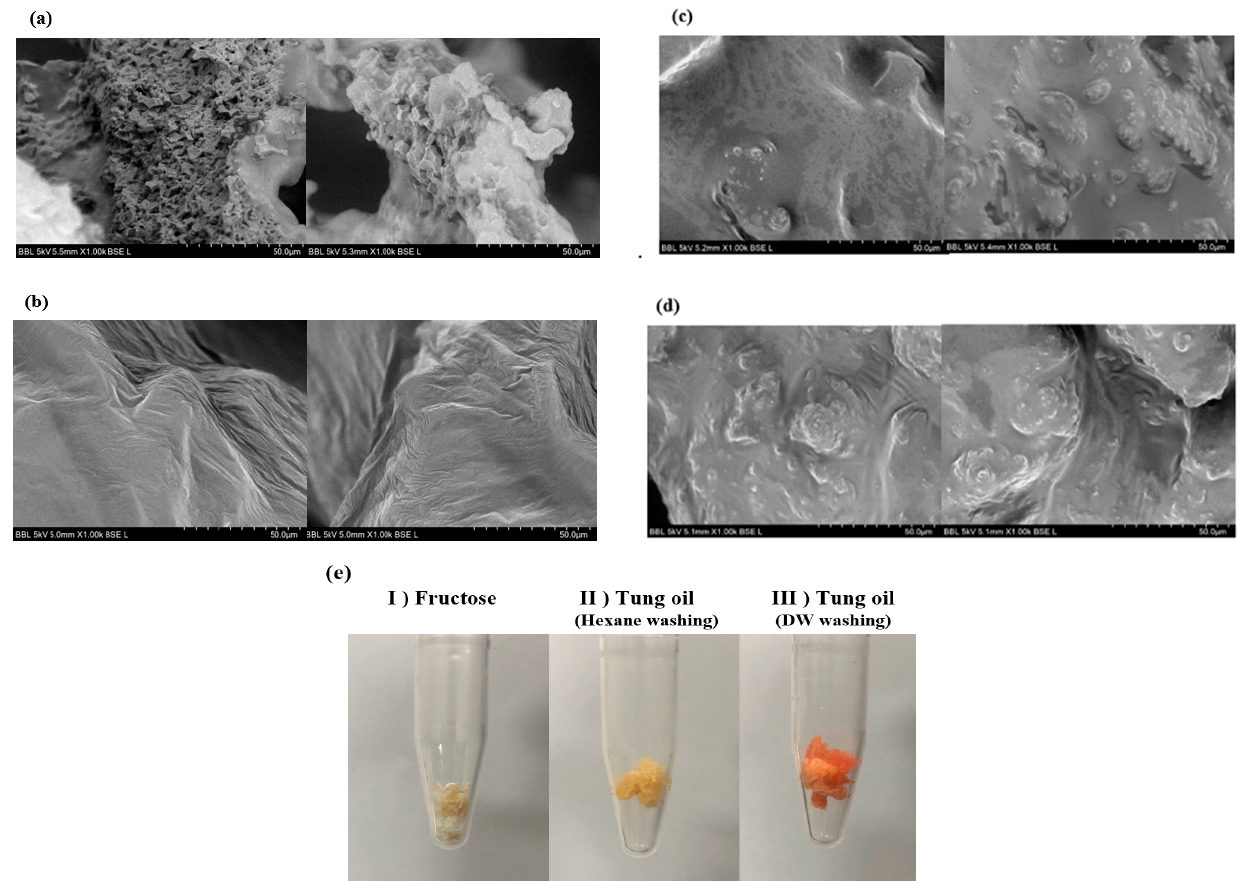
Figure 4. SEM images of the extracted polyhydroxyalkanoate (PHA) films. The surface of the PHA film produced using ( a ) fructose as the sole carbon source. The surface of the PHA film produced using tung oil and ( b ) washed twice with n-hexane, ( c ) washed once with n-hexane; ( d ) washed twice with deionized water; ( e ) Color differences among the films due to remaining tung oil.